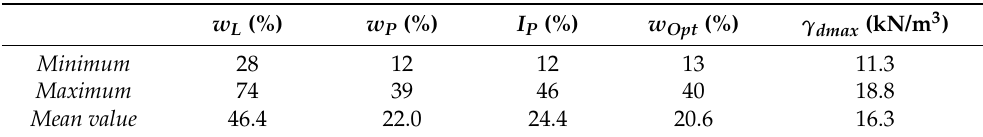
Table 4. Statistical parameters of soils taken from [30].